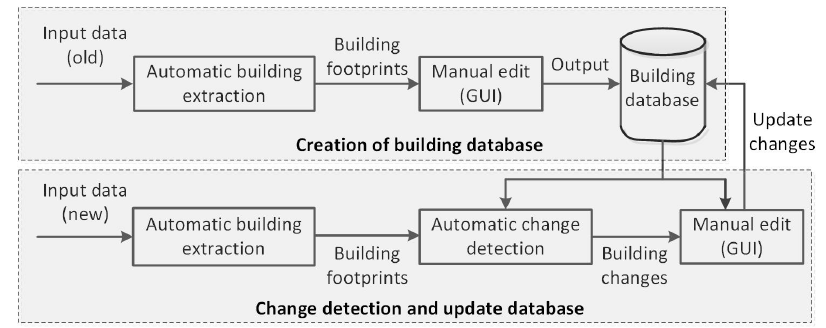
Figure 1. Flow diagram for the proposed creation and update of the building